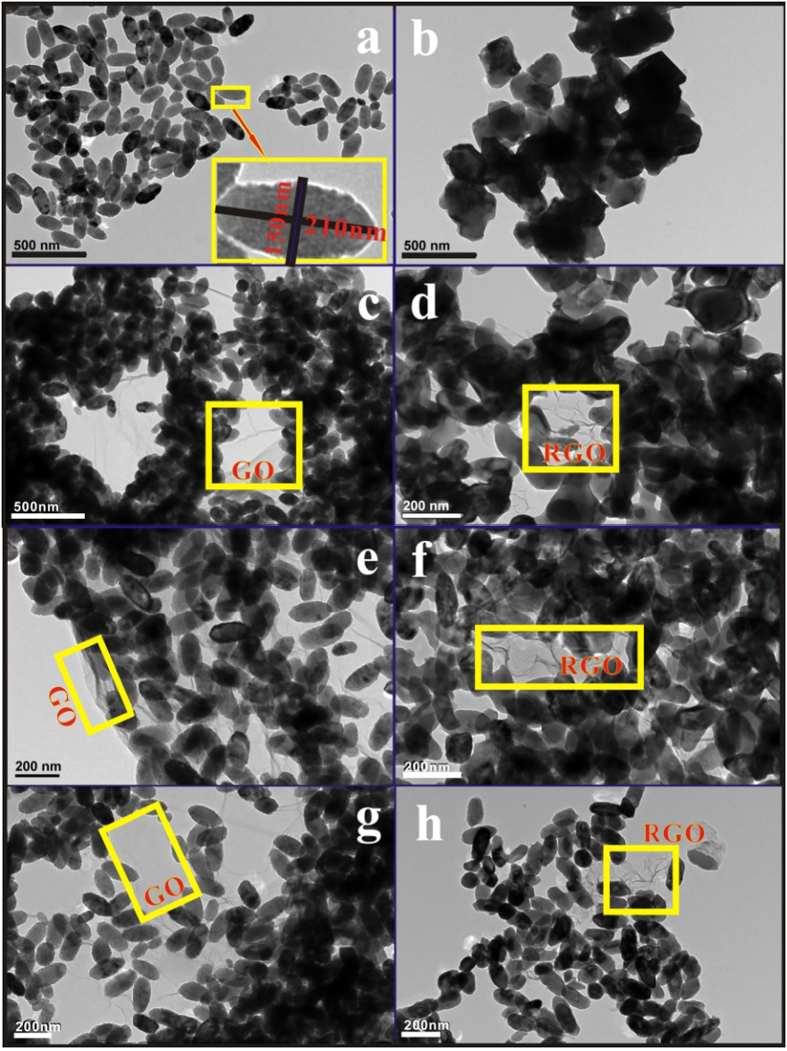
The TEM images of (a) the as-prepared α-Fe2O3, (b) Fe3O4 nanoparticles, (c) α-Fe2O3/1 wt.% GO, (d) Fe3O4/1 wt.% RGO, (e) α-Fe2O3/3 wt.% GO, (f) Fe3O4/3 wt.% RGO, (g) α-Fe2O3/5 wt.% GO and (h) Fe3O4/5 wt.% RGO nanocomposites.